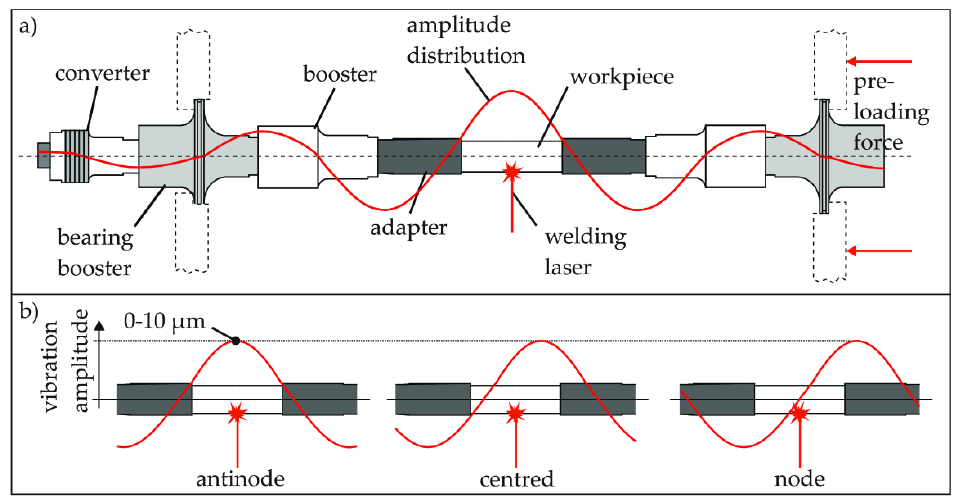
Figure 3. Ultrasonic system for laser beam welding of round bars with vibration distribution ( a ) and selected positions for welding tests ( b ).